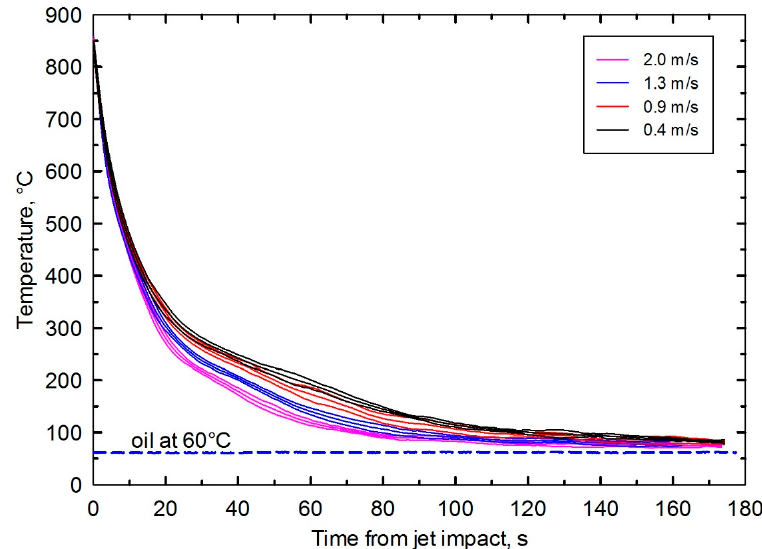
Figure 7. Effect of jet impact velocity on the average thermal evolution and corresponding 95% confidence interval.